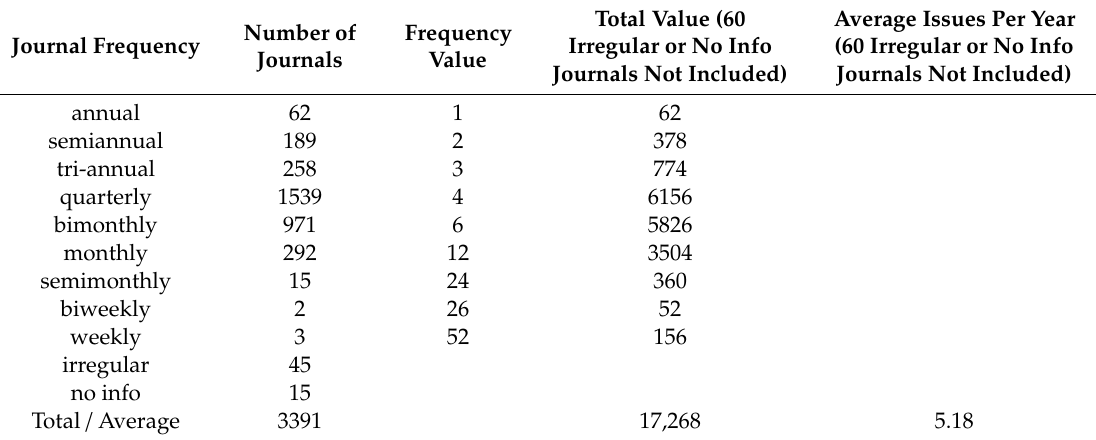
Table 2. Social Sciences Citation Index (SSCI) journals’ frequency—all journals’